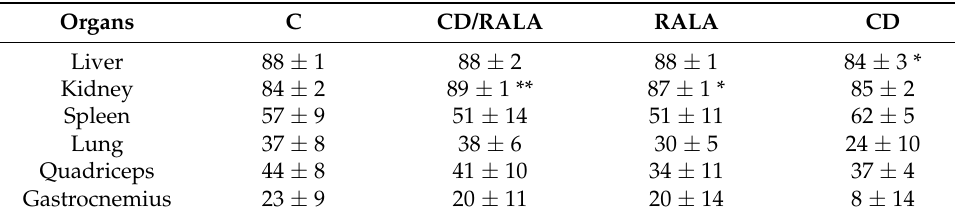
Values are expressed as the mean ± SD for six mice in each group. * , ** Significant difference from the control group ( p < 0.05, p < 0.01). C, control group; CD/RALA, R- α lipoic acid γ -cyclodextrin complex group; RALA, R- α lipoic acid group; CD, γ -cyclodextrin